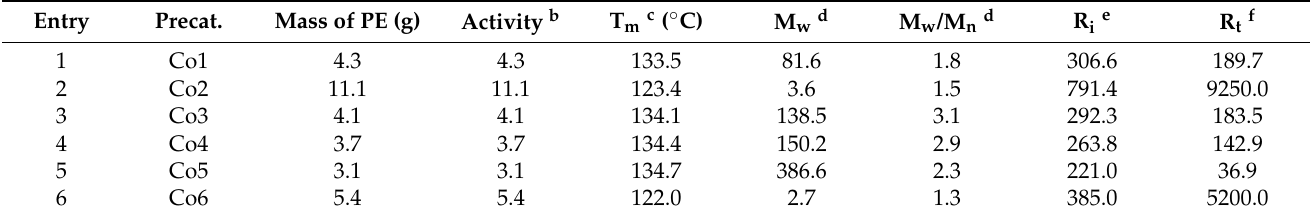
Table 5. Ethylene Polymerization using Co1 – Co6 with MMAO as the co-catalyst a